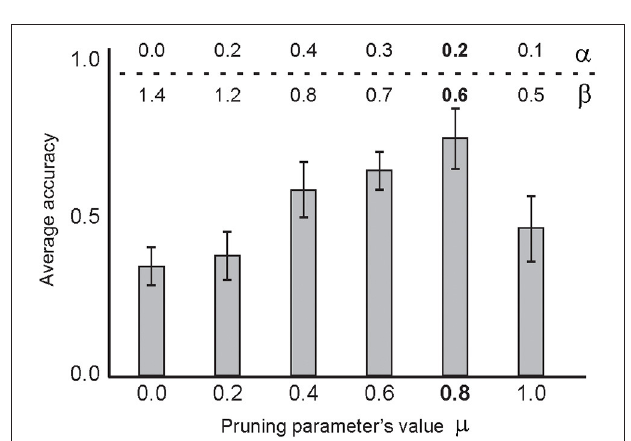
FIGURE 11 | The dependency of classification accuracy on the connectivity rate of the second and third neural layers. Average classification accuracy was measured for different connectivity rates between 0 to 1 by training the network with 10 selected samples and testing on the entire training set. The results show maximum classification accuracy for rates set to 0.2. In these experiments, α , β , and µ values were set as 0.2, 0.6, and 0.8,